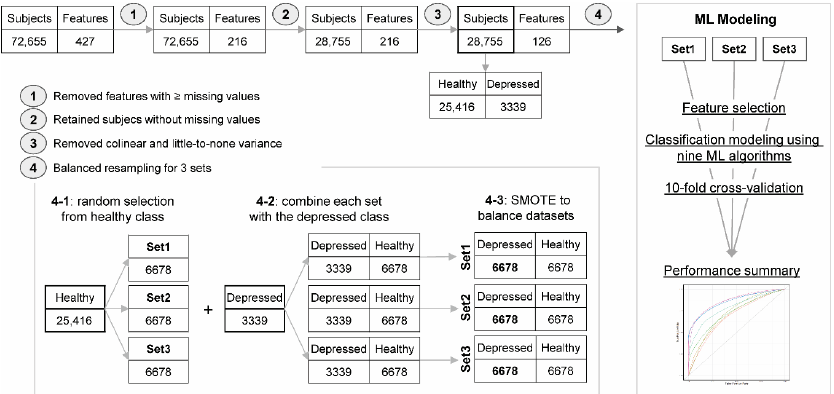
Figure 1. The overall process of data preprocessing and imbalance handling. Data preprocessing included (1) removal of features with more than 10,000 missing values; (2) removal of observations with missing values; and (3) removal of non-informative features with colinear or little-to-none variance. The resulting “cleansed” dataset was split to create three distinct datasets and synthetic minority oversampling technique (SMOTE) was used to balance these datasets in (4), which were used for classification model building and